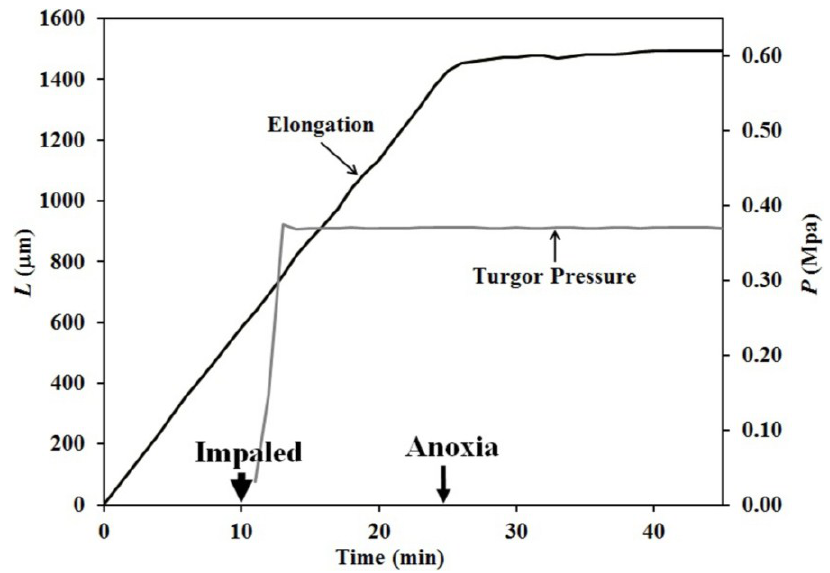
Figure 3. Both the change in elongation and turgor pressure of a Stage IV sporangiophore are plotted as a function of time. The turgor pressure was held constant with the pressure probe during